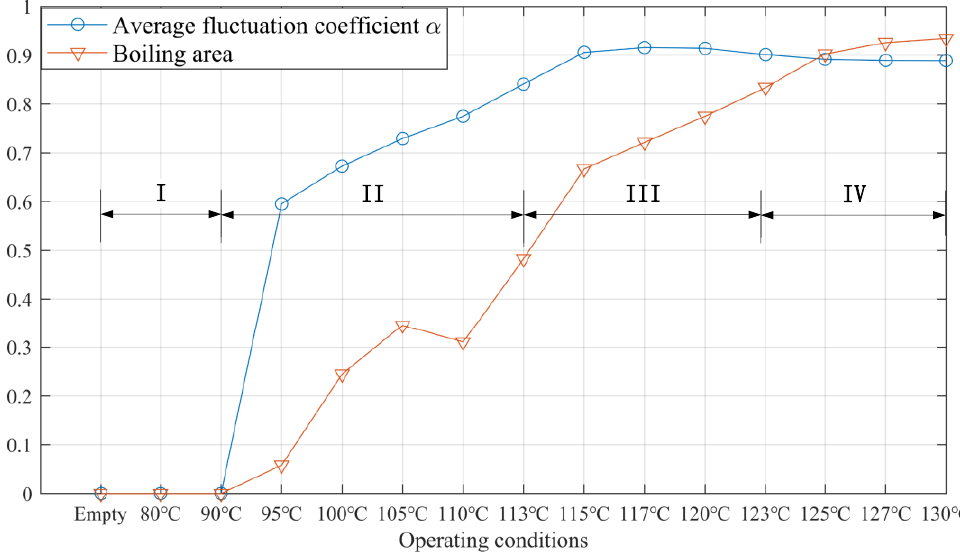
Figure 14. Boiling area and average fluctuation coefficient (normalized) of the considered heating conditions, divided into four stages.